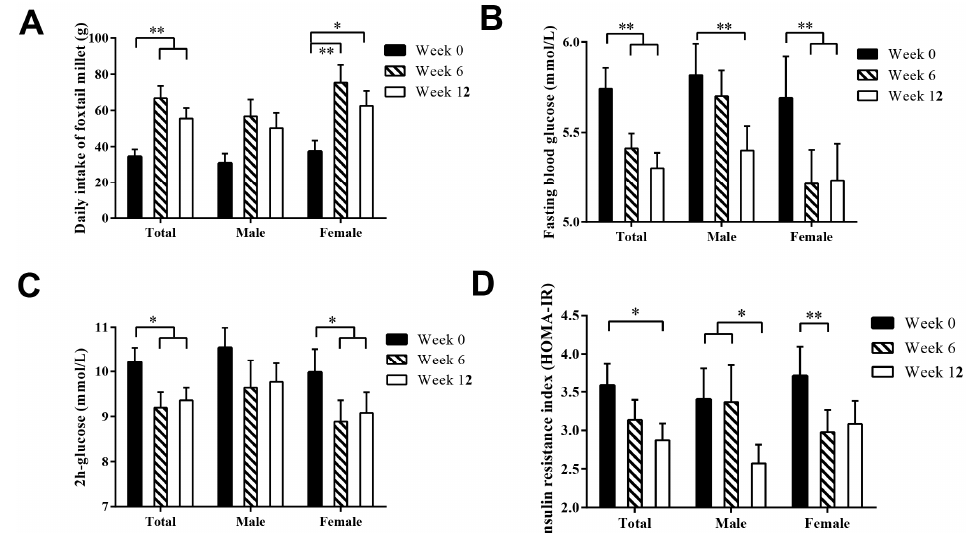
Figure 2. Sex-dependent difference in daily intake of foxtail millet ( A ), fasting blood glucose ( B ), 2 h-glucose ( C ) and insulin resistance index ( D ) in subjects with impaired glucose tolerance. Difference between two different time points was examined using Bonferroni’s post-hoc test. All statistical tests were 2-sided, and * p < 0.05 and ** p < 0.01 were considered statistically significant.